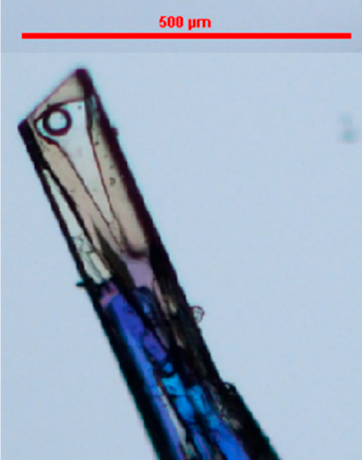
10 of 14 Table 1. Comparison between the lattice parameters of the ss-S-IBU/S- α MBA with a composition of X R-IBU/S- α MBA = 0.14 (powder), the single crystal (X R-IBU/S- α MBA ≈ 0.18), and the pure salt S-IBU/S- α MBA (powder). Data obtained from the software Material Studio. a (Å) b (Å) c (Å) X RS = 0,14 from powder diffraction